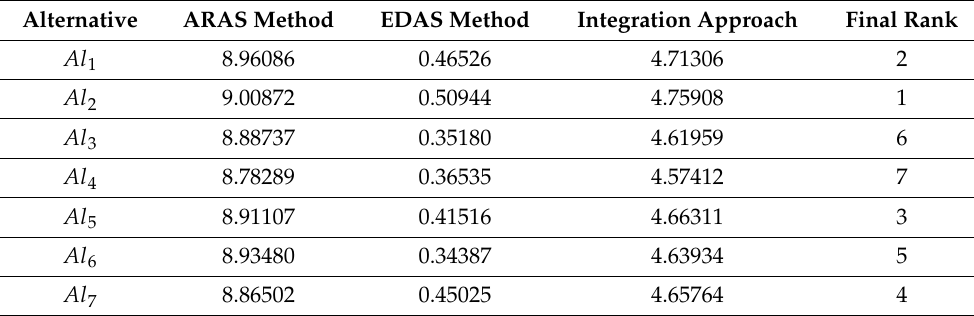
Table 14. Ranking of